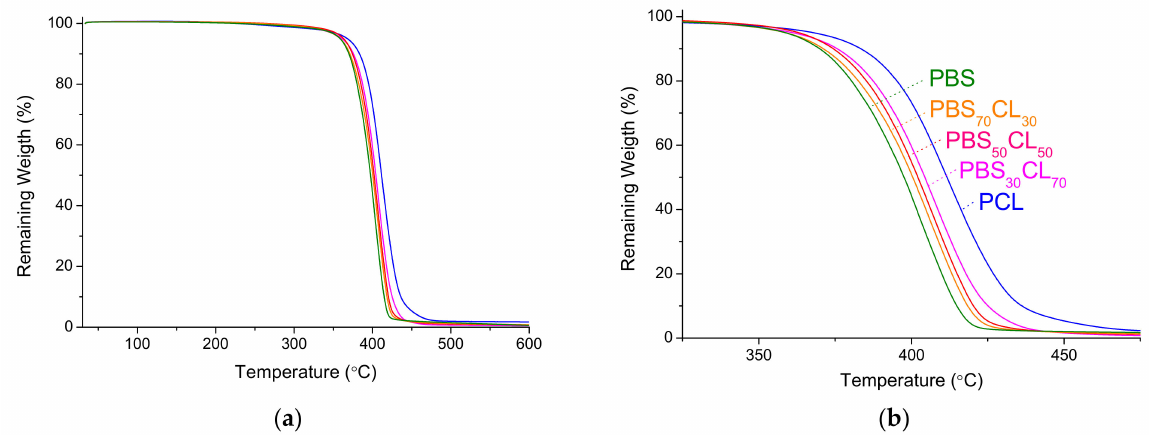
Figure 7. Thermogravimetric traces of PBS, PCL, and PBS x CL y copolyesters. ( a ) Full TGA traces; ( b ) expanded region where the thermal degradation with weight loss is